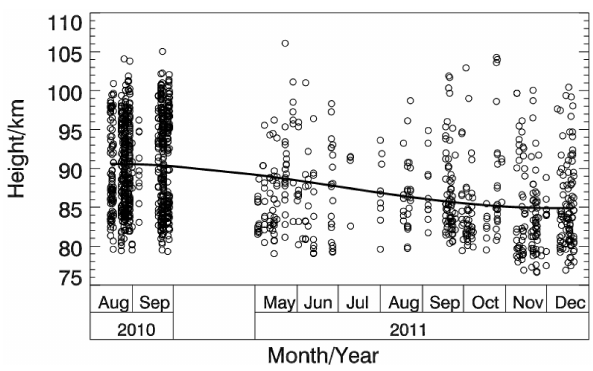
Figure 2. Long-term variation of the occurrence height of the